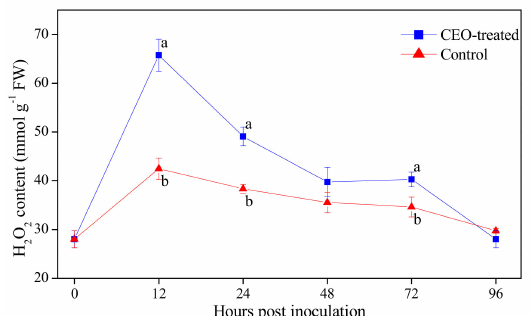
Figure 1. H 2 O 2 content in citrus fruit treated with CEO (0.4%, v / v ) infected with P. italicum , and incubated at 25 ◦ C for 96 h. Each value represents the mean of three replicates ± standard error (S.E.). Di ff erent lowercase letters indicate significant di ff erences ( p < 0.05) between CEO-treated and control group at the same time by Tukey HSD test.